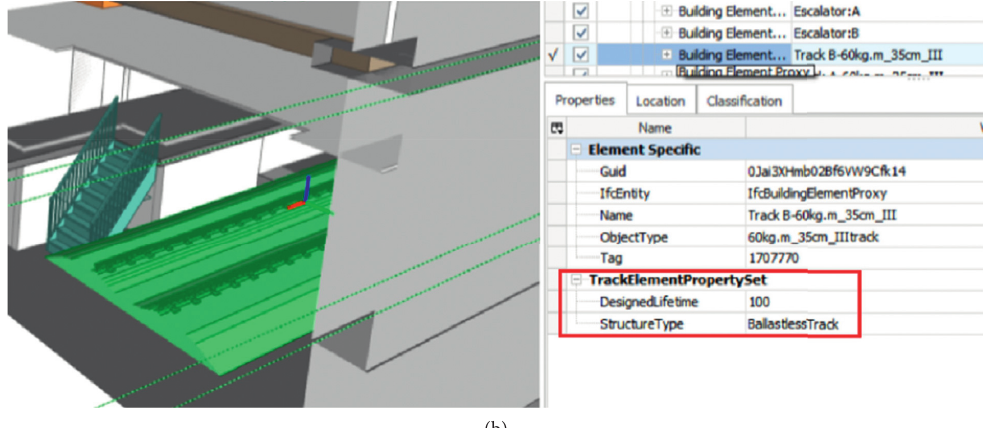
Figure 20: The property of Tracks A and B